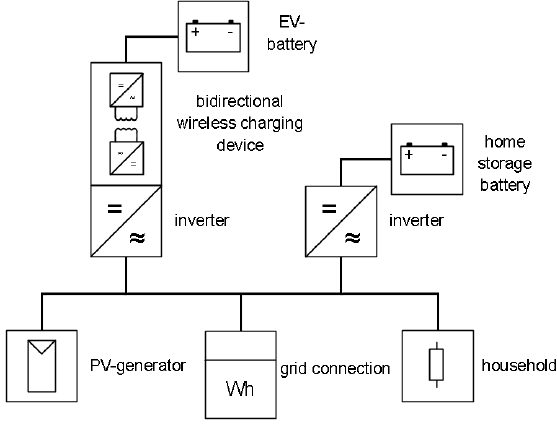
Figure 1. Household energy